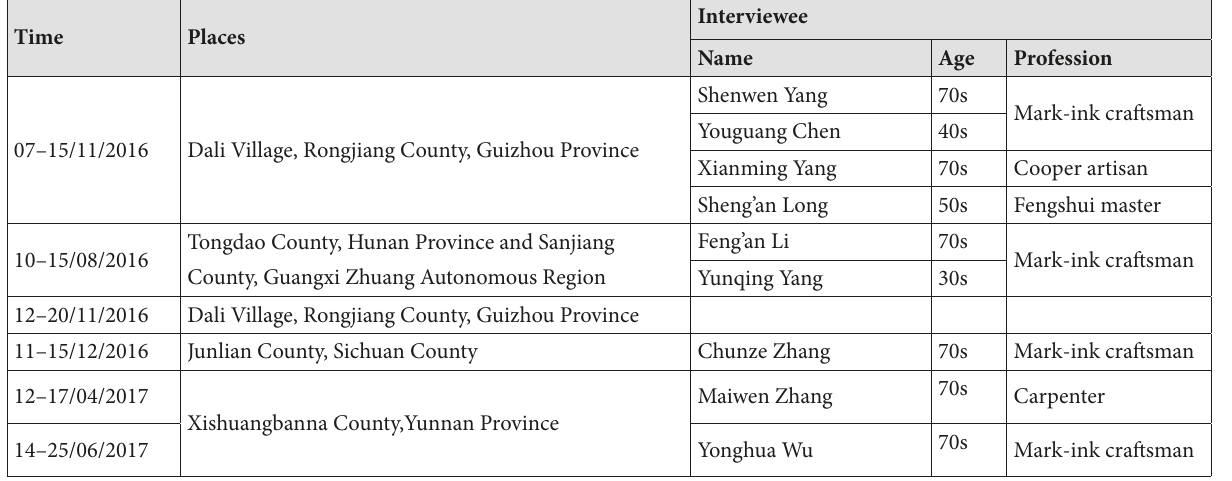
Table 1 Field work area and time (Source: Congcong